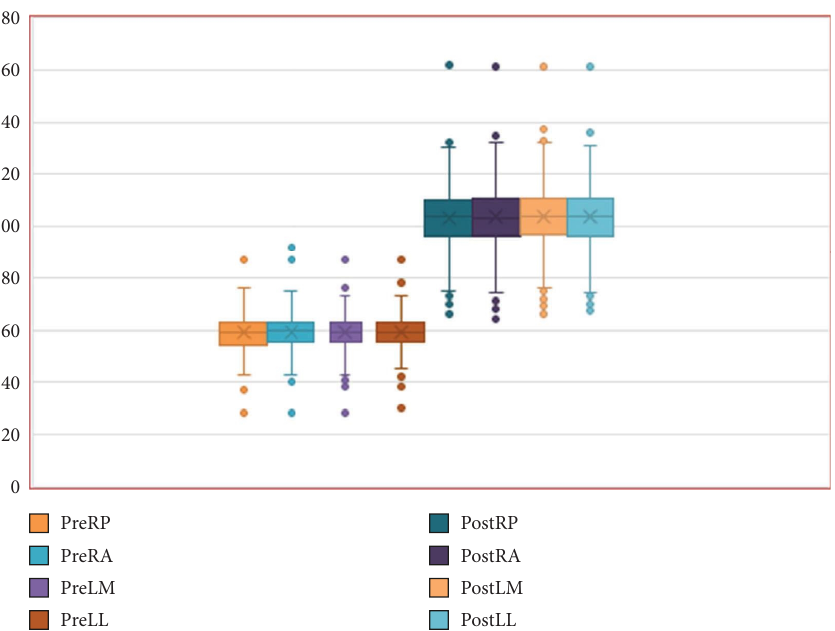
Figure 3: Box and Whisker plot illustrating the hepatic CTattenuations at the 4 locations in precontrast and portal venous scans. Tere is no signifcant variation in the hepatic attenuations at the locations, in both phases of the scans. RP � right posterior; RA � right anterior; LM � left medial; LL � left later. Table 1: Precontrast and portal venous phase hepatic attenuation measurements in patients with abdominal CTperformed at